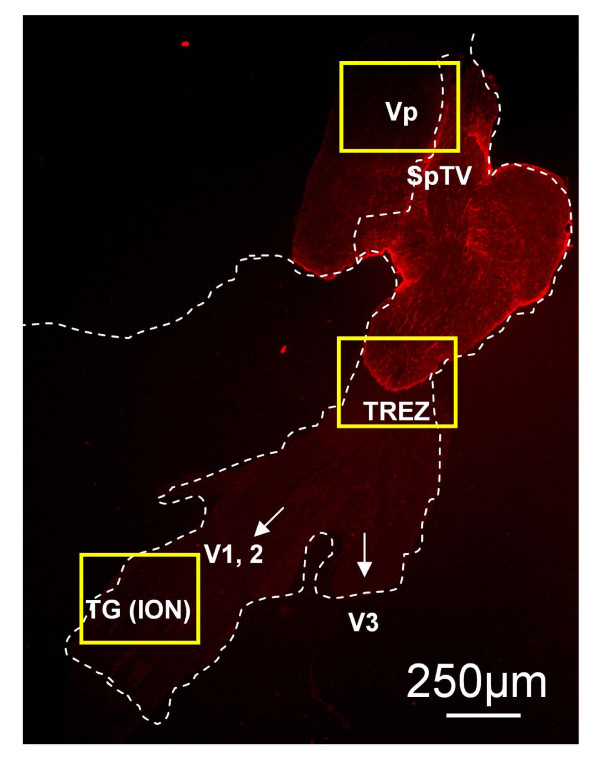
Orientation of VP, TREZ, TG.  Key areas for our analyses are shown here: (1) the trigeminal principle nucleus (Vp), (2) The root entry zone (TREZ) where central glia are in the CNS side (GFAP, red), and Schwann cells on the ganglion side, and (3) trigeminal ganglion (TG). The cell bodies for infraorbital nerve (ION) occur in the distal parts of the combined V1/V2 but not in V3. Yellow boxes show sites for quantification.